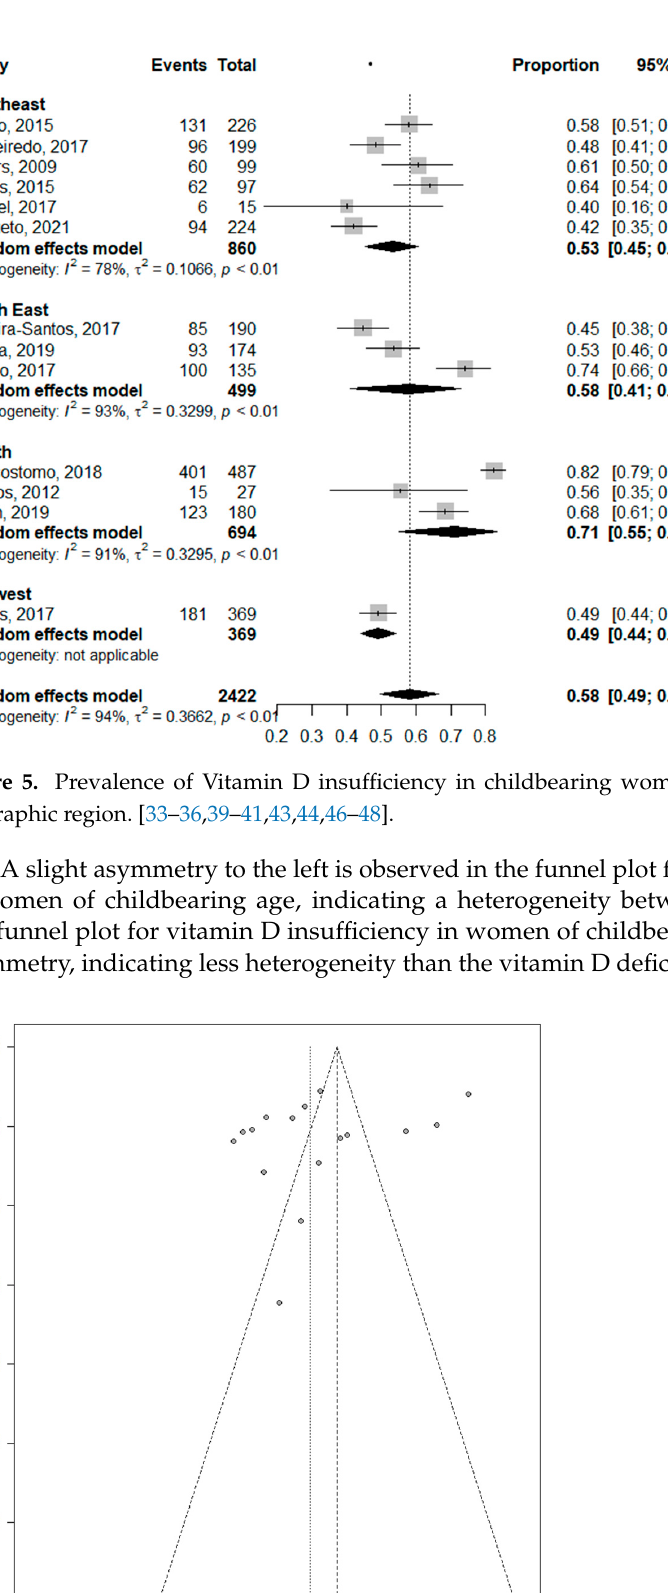
Figure 4. Prevalence of Vitamin D insufficiency in childbearing women stratified by pregnancy sta- tus. [33–36,39–41,43,44,46–49].